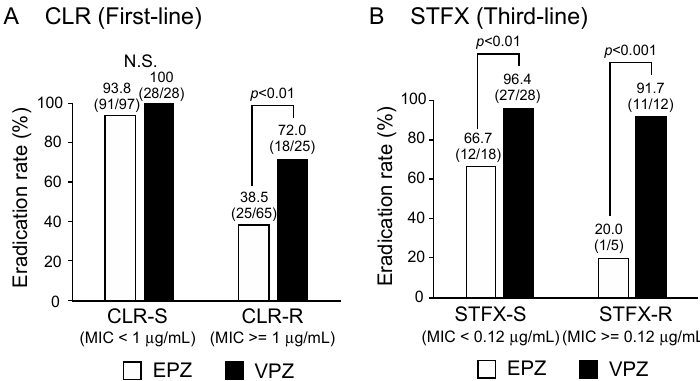
Figure 2. The success rates (PP) of first- and third-line eradication for drug-susceptible or resistant H. pylori with VPZ-based triple therapy and EPZ-based triple therapy. ( A ) The first-line eradication rate for CLR-resistant H. pylori (minimum inhibitory concentration, minimum inhibitory concentrations (MIC) ≥ 1 µg/mL) was significantly higher for VPZ-based triple therapy (72.0%) than for EPZ-based triple therapy (38.5%, p < 0.01), whereas there was no significant difference in the first-line eradication rate for CLR-susceptible H. pylori (MIC < 1 µg/mL). ( B ) The third-line eradication rate for STFX-resistant H. pylori (MIC ≥ 0.12 µg/mL) was significantly higher for VPZ-based triple therapy (91.7%) than for EPZ-based triple therapy (20.0%, p < 0.001). The third-line eradication rate for STFX-susceptible H. pylori (MIC < 0.12 µg/mL) was also significantly higher for VPZ-based triple therapy (96.4%) than for EPZ-based triple therapy (66.7%, p < 0.01).